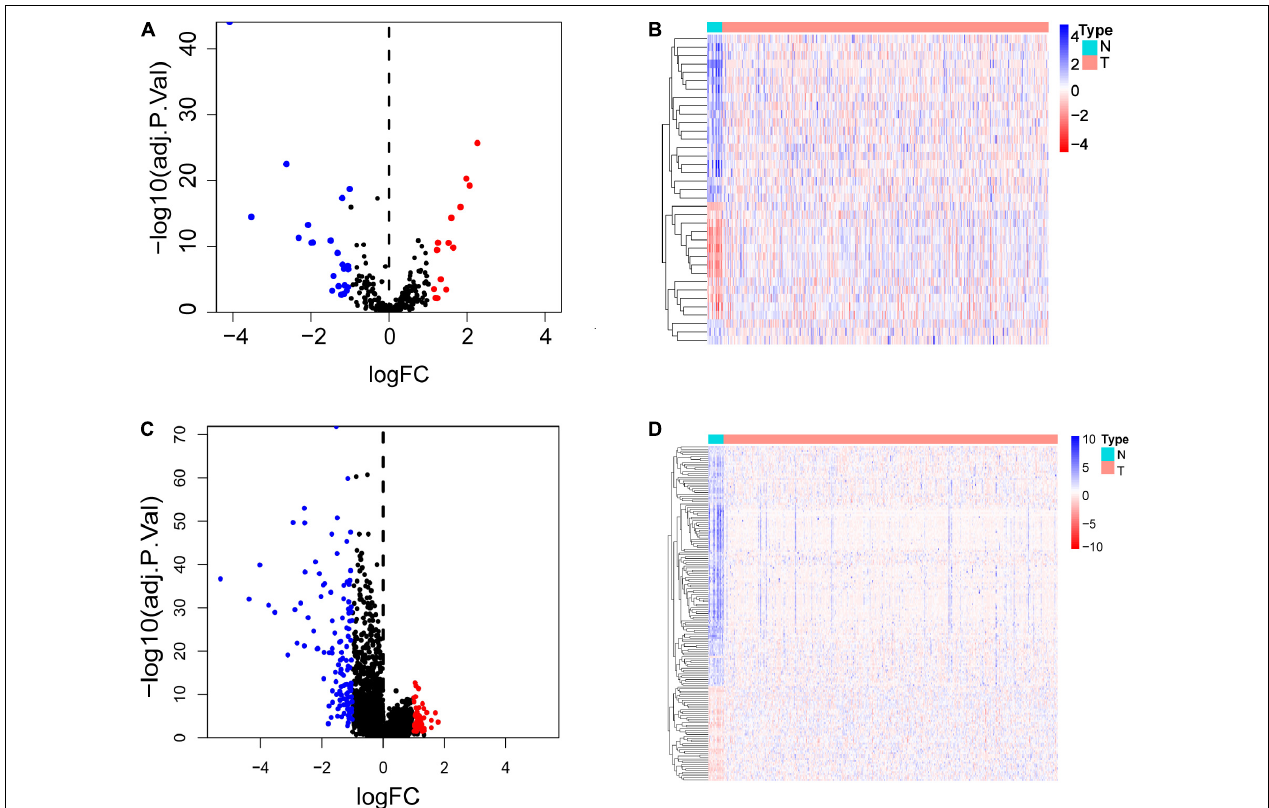
FIGURE 2 | Differentially expressed glycolysis-related genes and lncRNAs in bladder cancer compared to pericarcinomatous tissues. (A,B) Volcano plot and heat map of glycolysis-related genes differentially expressed in bladder cancer tissue and pericarcinomatous tissue. (C,D) Volcano plot and heat map of lncRNAs differentially expressed in bladder cancer tissues and pericarcinomatous